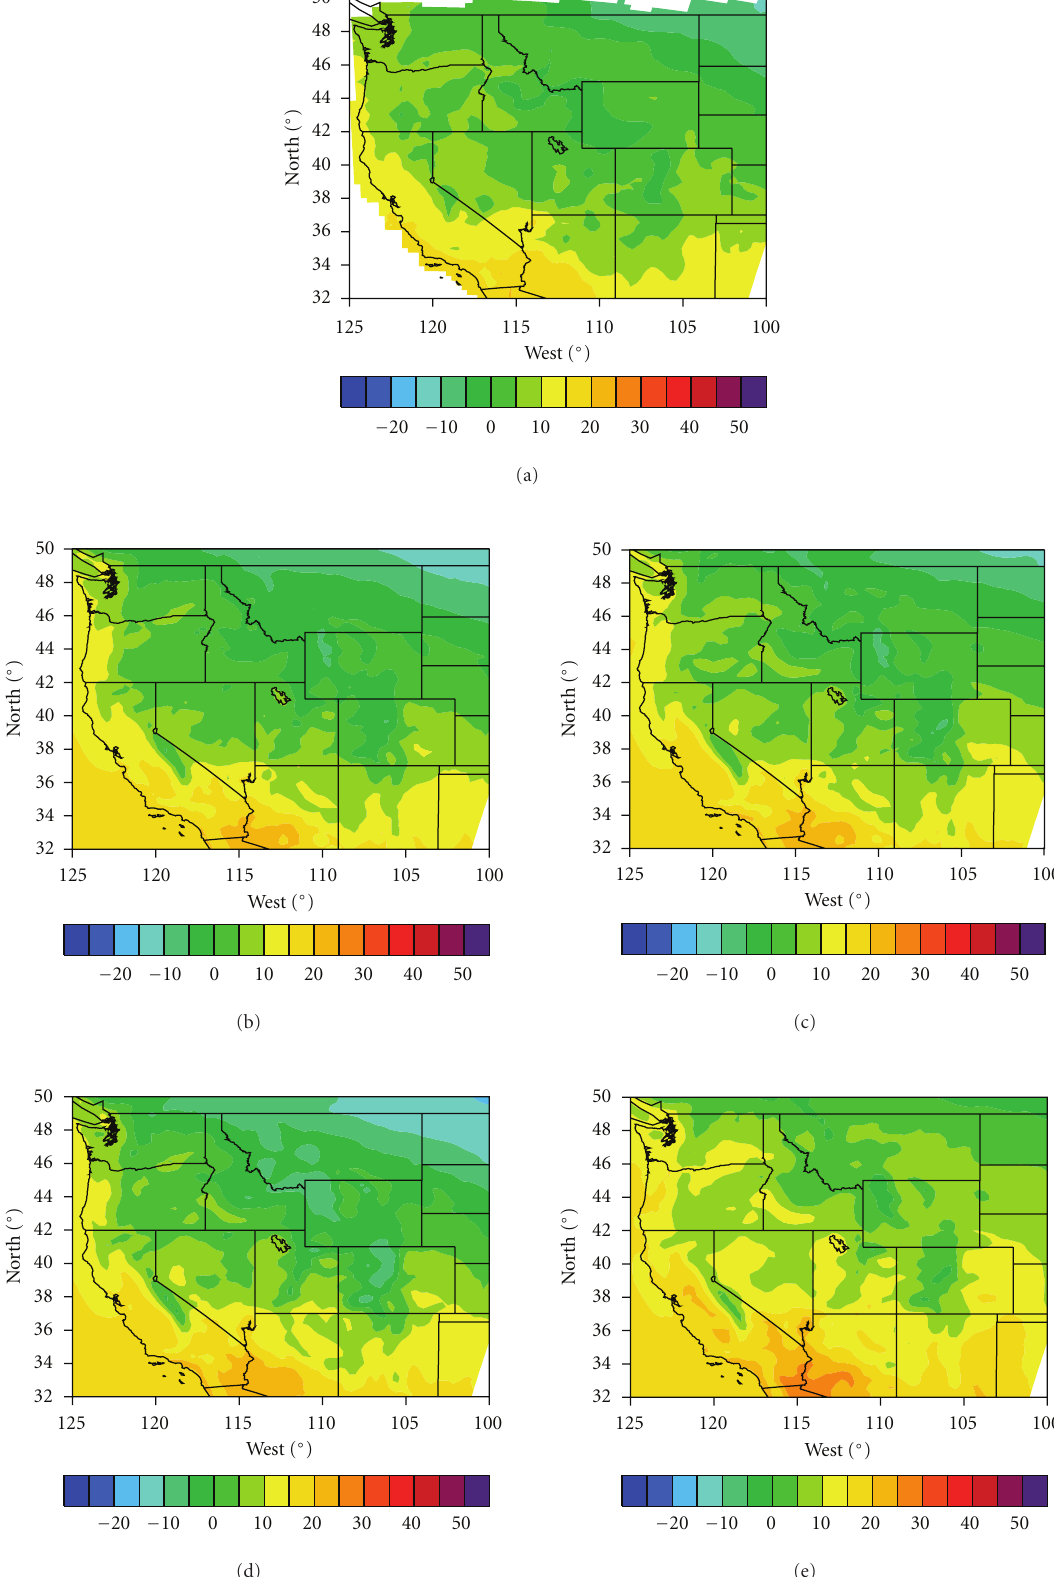
Figure 4: The geographic distribution of observed and WRF-simulated winter (December, January, and February) daily maximum temperature (Unit: ◦ C). (a) Observations; (b) CLM3; (c) Noah; (d) RUC; (e)